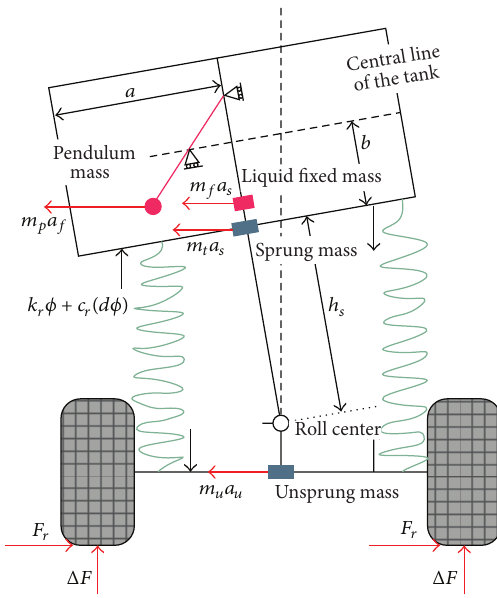
Figure 5: Back view of vehicle dynamic analysis.